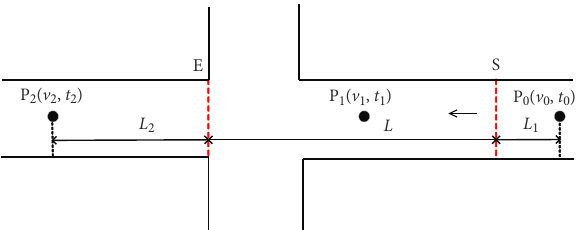
Figure 7. Schematic of the control delay calculation for reference